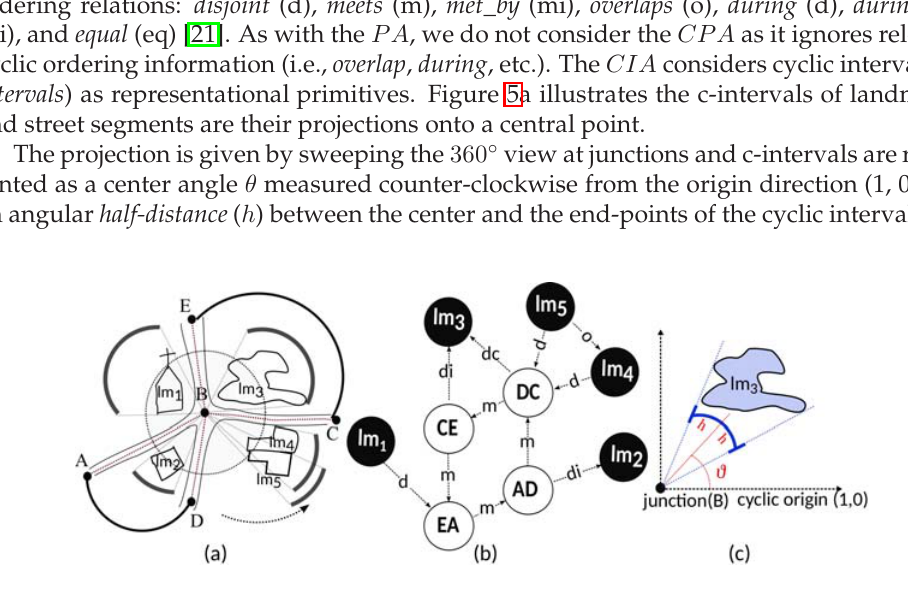
Figure 5: (a) The c-intervals of drawn objects around a reference junction, (b) cyclic ordering between objects using the coarse CIA relations, and (c) the projected c-interval of landmark ( lm 3 ) on the junction